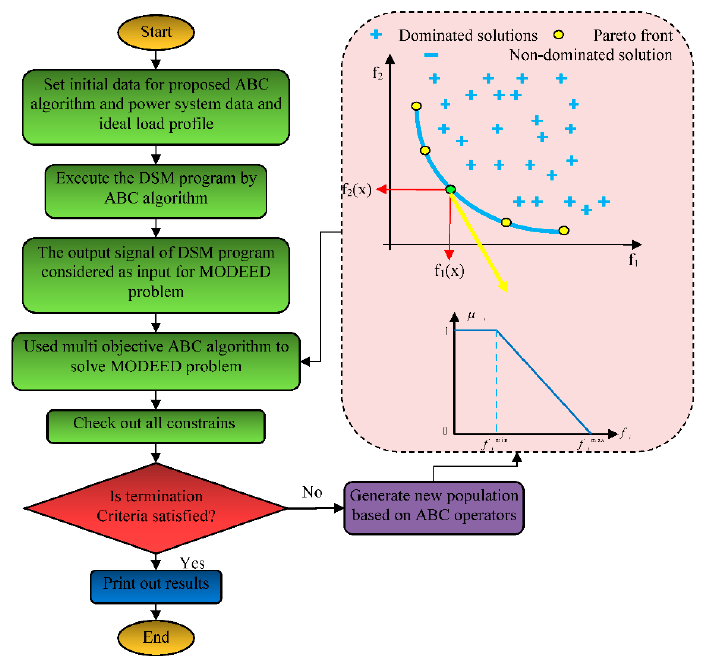
Figure 3. Simplified flowchart of compound DSM and MODEED models.